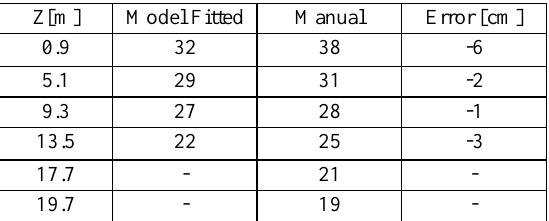
Table 3. Diameter comparison of a single tree